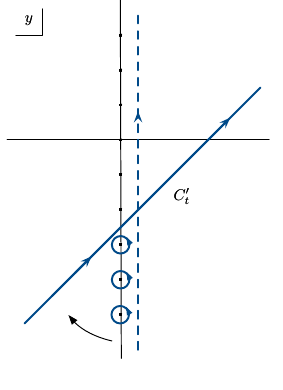
Figure 2. The case of H ≥ 2